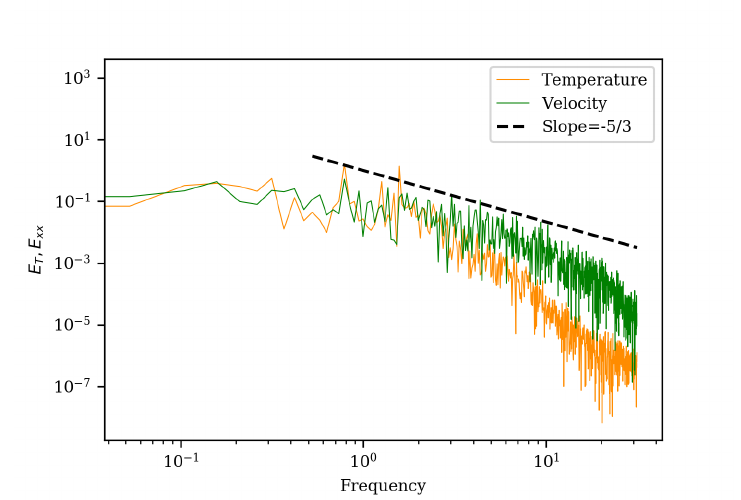
Figure 10. Spectrum of velocity and temperature data showing a significant difference in the scalar turbulence in liquid metal flow.